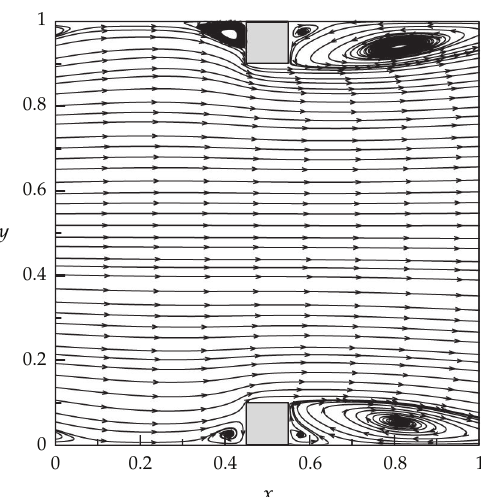
Figure 9: Time-averaged streamline on mid-transverse plane (cid:2) z (cid:8) 0 . 5 (cid:3)